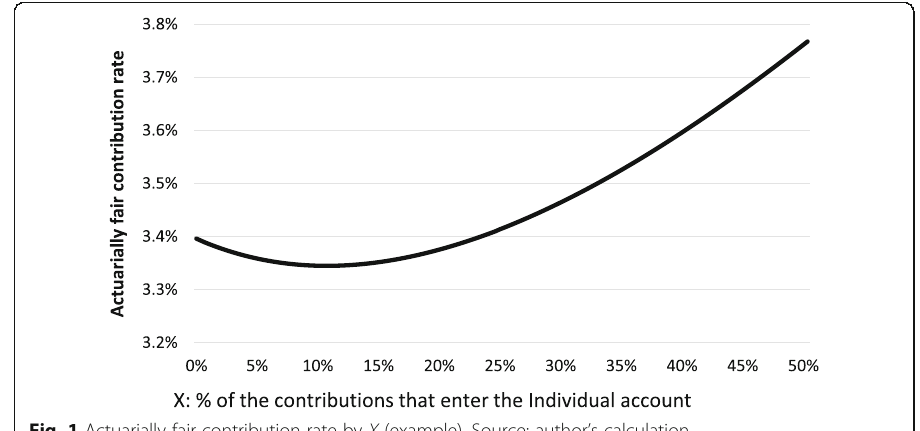
Fig. 1 Actuarially fair contribution rate by X (example). Source: author ’ s